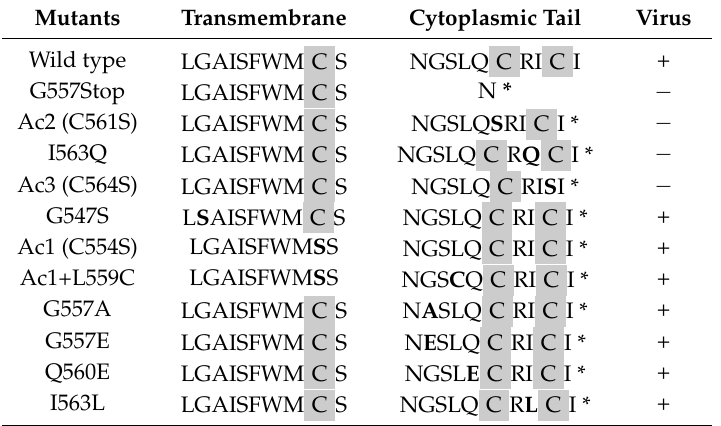
Table 1. Mutations introduced in the transmembrane region and cytoplasmic tail of hemagglutinin (HA). Amino acid sequence of the transmembrane region and cytoplasmic tail of HA from the A/WSN/33 (H1N1) strain. Acylated cysteine residues are highlighted in grey, introduced amino acid exchanges are in bold. An asterisk indicates a stop codon. + or ´ indicates whether infectious virus could be rescued by transfection of